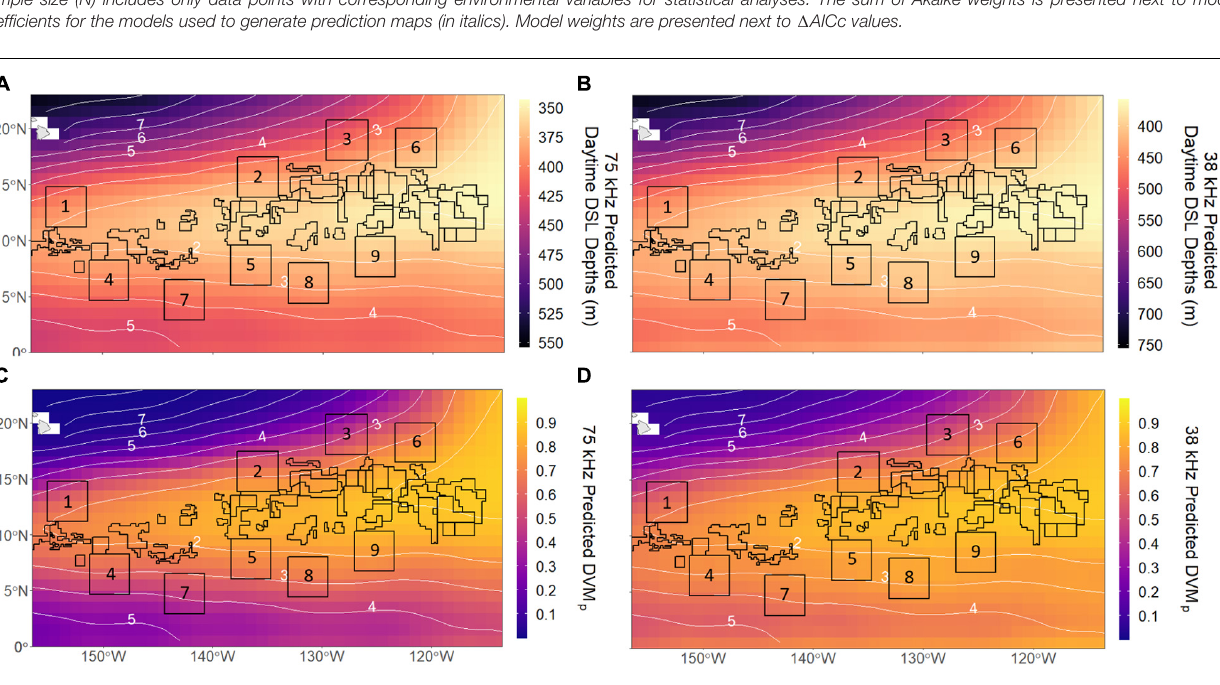
FIGURE 5 | Annual mean 1 × 1 ◦ predictions for daytime deep scattering layer (DSL) depths at (A) 75 kHz and (B) 38 kHz and vertical migration proportions (DVM p ) at (C) 75 kHz and (D) 38 kHz across the CCZ. Numbered boxes indicate Areas of Particular Environmental Interest (APEIs) and all other polygons represent mining exploration claim areas designated by the International Seabed Authority (ISA). White numbered contours represent mean midwater oxygen partial pressure (pO 2 ;